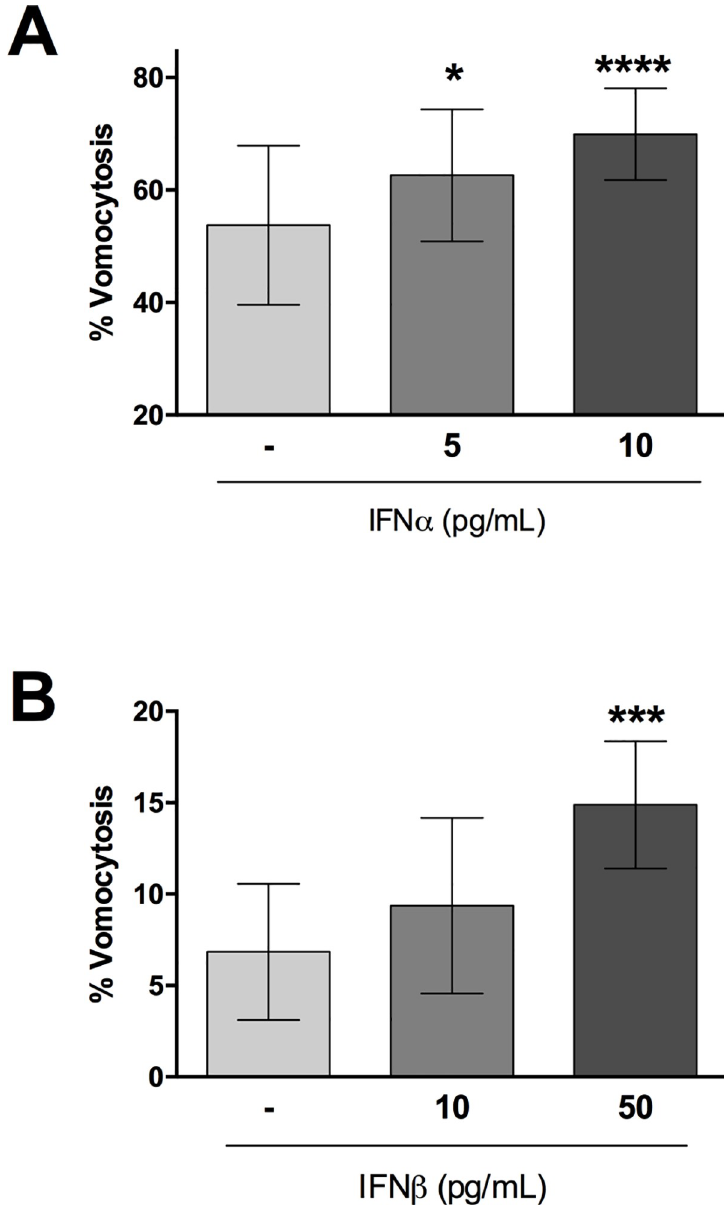
Fig 5. Antiviral response increases vomocytosis. Human monocyte-derived macrophages were stimulated with different doses of IFN α ( A ) or IFN β ( B ), and infected with C . neoformans . Graphs show Mean + SD of percentage of Cryptococcus -infected macrophages which have experienced at least one vomocytosis event. Chi 2 test followed by Fisher’s exact test performed on raw vomocytosis counts. Pooled data from at least three independent experiments.